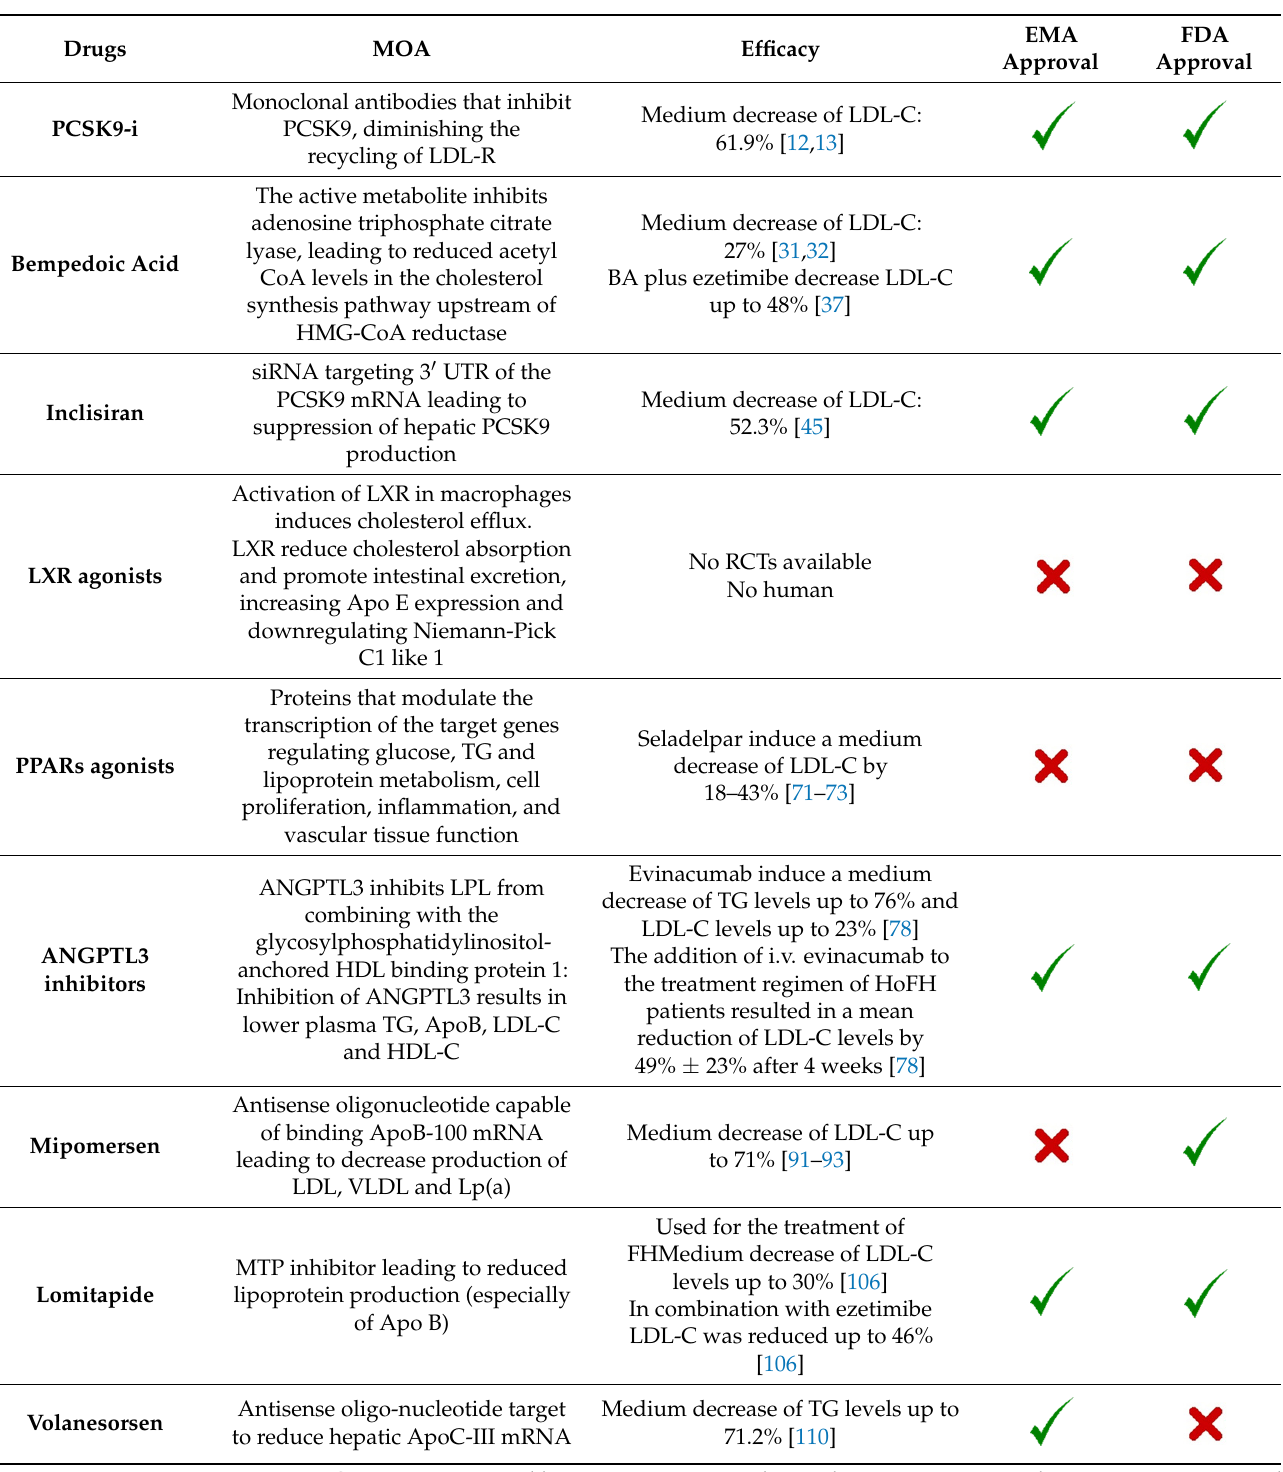
Table 2. Summary of indications, contraindications, and main side effects of the novel Lipid Low- ering agents. Drugs